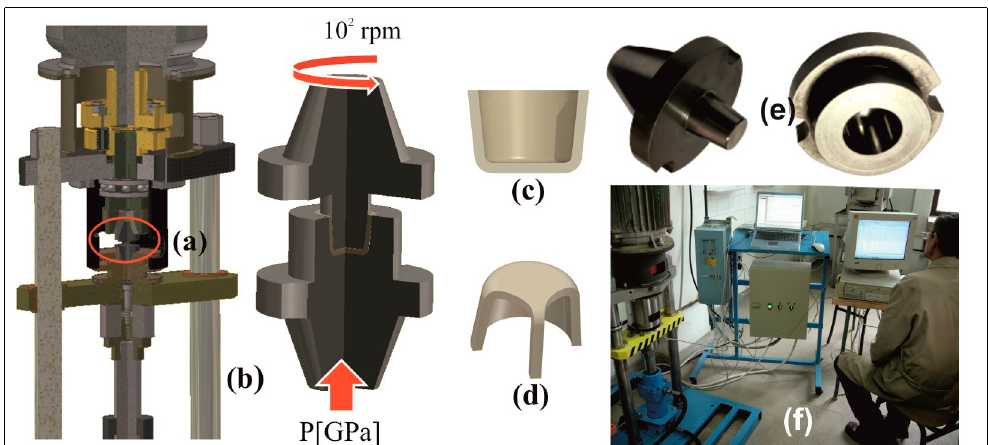
Figure 1. Processing of the blanks by High Speed High Pressure Torsion. ( a , b ) HSHPT scheme, ( c , d ) compression staples blank, ( e ) HSHPT tools, ( f ) HSHPT experimental setup.